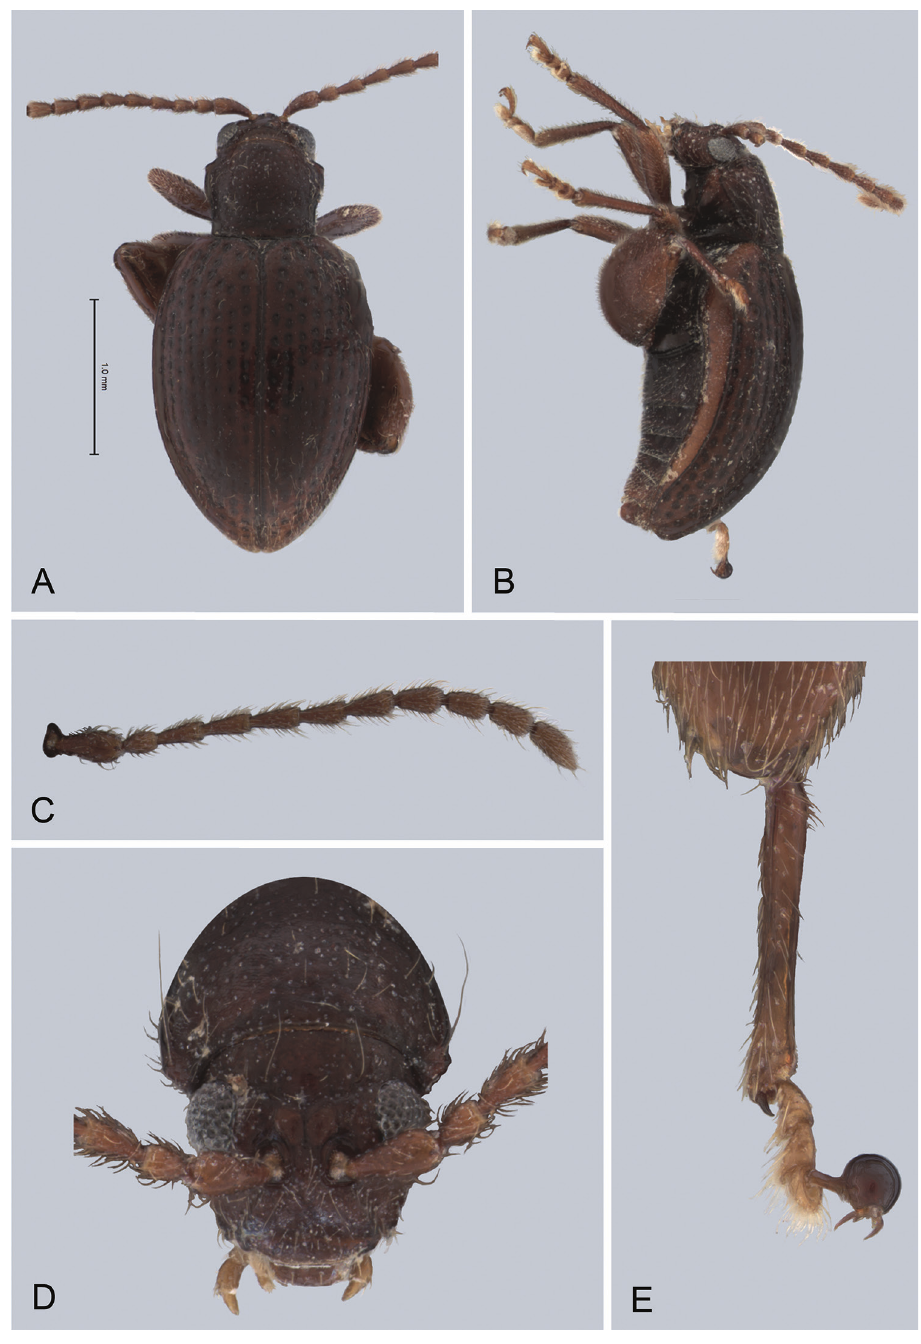
Figure 32. Andersonoplatus sanare . A Habitus dorsal B Habitus lateral C Antenna D Head, frontal view E Hind